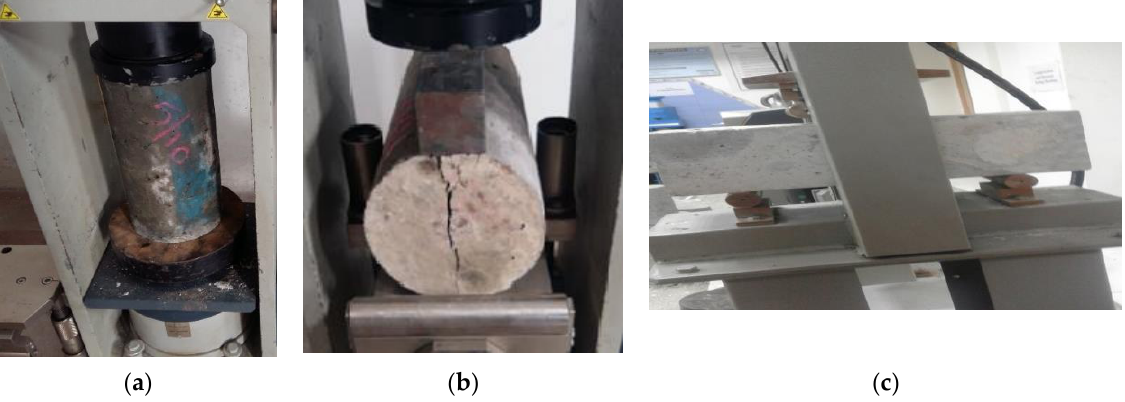
Figure 5. Test performance: ( a ) compressive strength, ( b ) splitting tensile strength, ( c ) flexural strength.